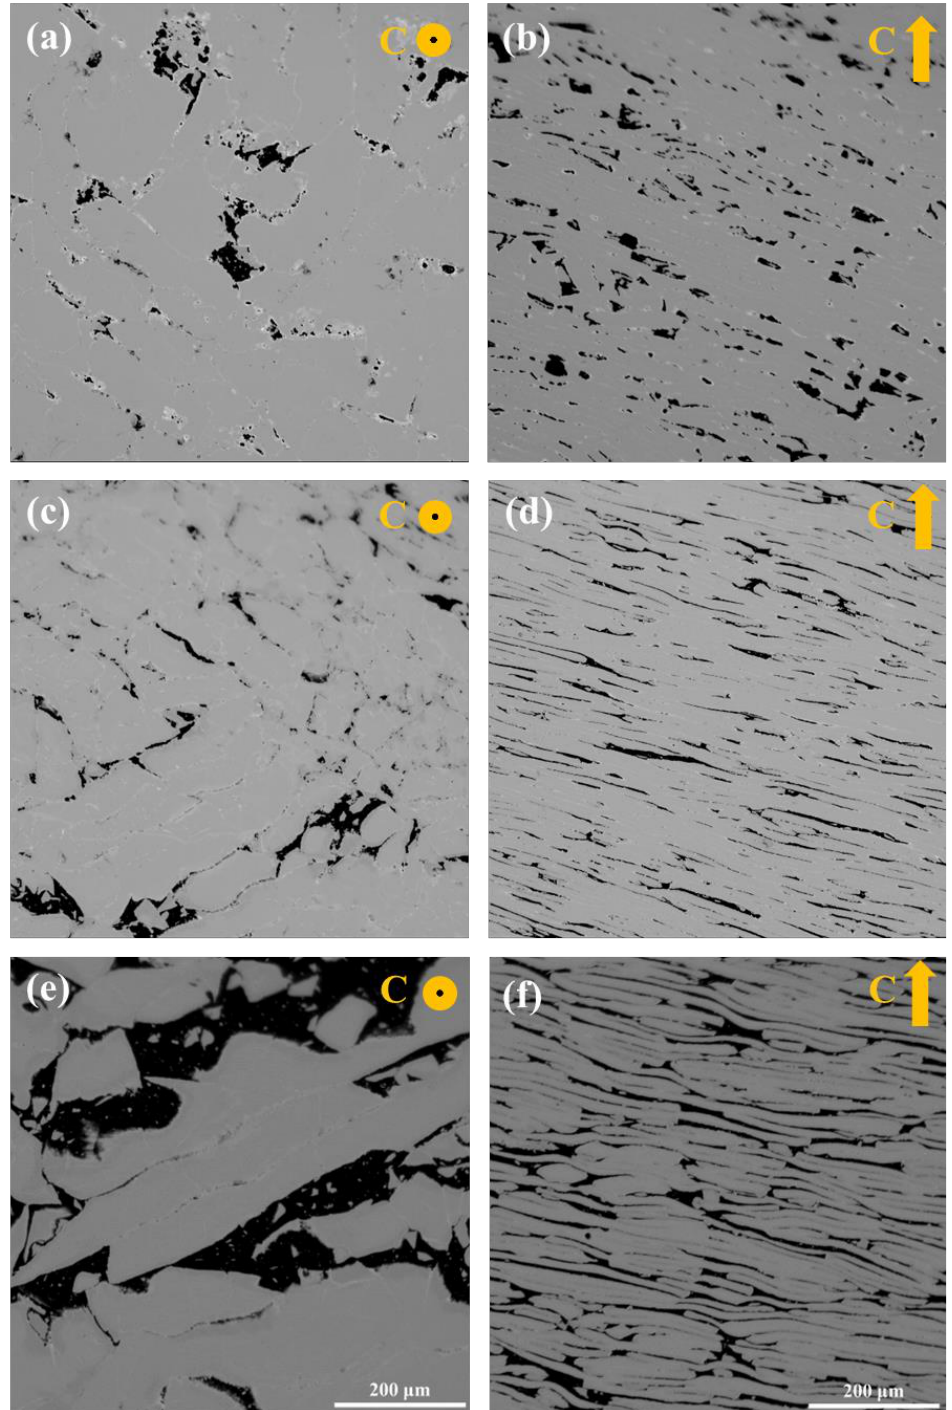
Figure 2. The same magnification BSE-SEM images obtained from ( a , b ) hot-deformed magnet with 2wt.% glass fiber, ( c , d ) with 5wt.% glass fiber, ( e , f ) with 10wt.% glass fiber. Furthermore, the direction of images ( a , c , e ) are parallel to the pressure, and ( b , d , f ) are perpendicular to the pressure, yellow arrows and circles indicate different C-axis orientations of the magnet.